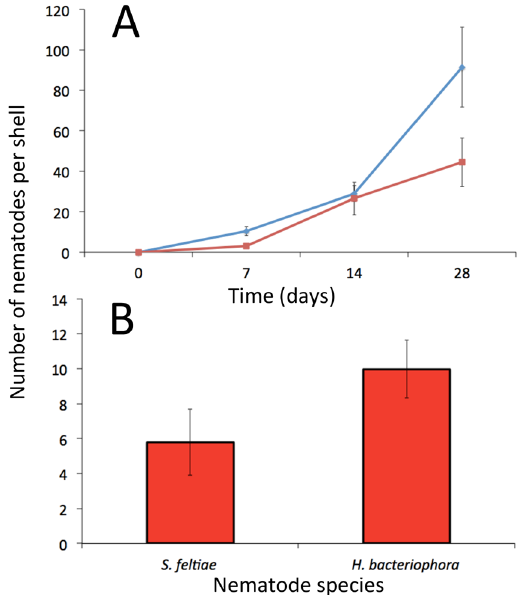
Figure 2. C. nemoralis can trap and kill different nematode species. Mean number of P. hermaphrodita C11 (blue) and C25 (red) found encased in C. nemoralis shells after 7, 14 and 28 days infection ( A ) (n = 10 C. nemoralis for each time point exposed to each strain). Mean number of S. feltiae and H. bacteriophora in C. nemoralis shells (n = 10 and n = 30, respectively) after 7 days exposure ( B ). Bars represent ± one standard error.